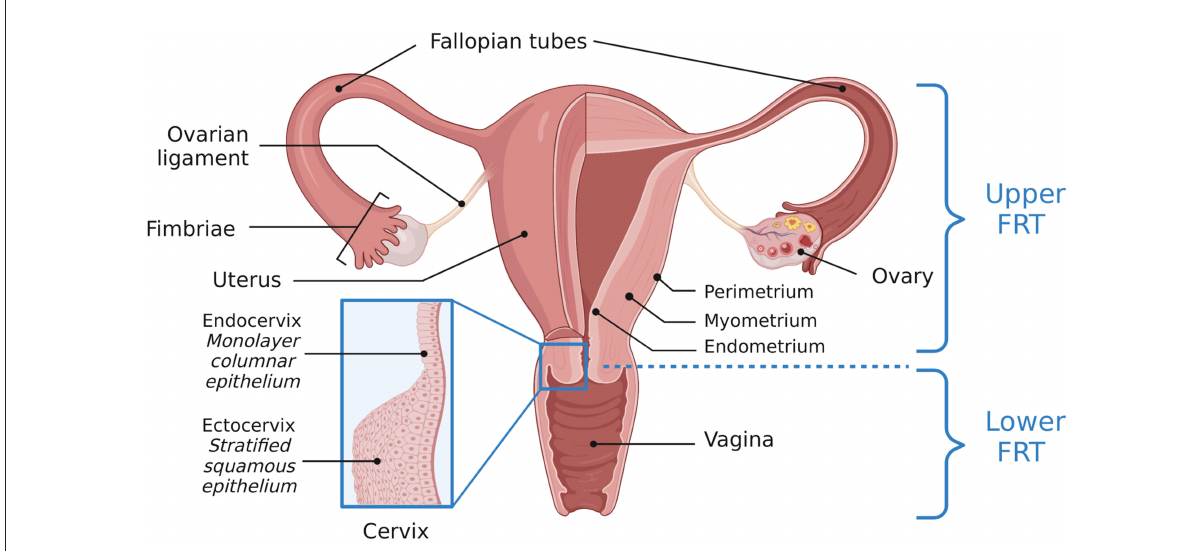
FIGURE1 Anatomy of the female reproductive tract. A visual depiction of the female reproductive tract (FRT), further subdivided into the upper and lower reproductive tract. The lower reproductive tract consists of the vagina and ectocervix, lined by a stratified squamous epithelium. The endocervix, lined by a monolayer columnar epithelium, and the uterus, Fallopian tubes and ovaries comprise the upper reproductive tract. Adapted from “Female Reproductive System Anatomy,” by BioRender.com (2022). Retrieved from